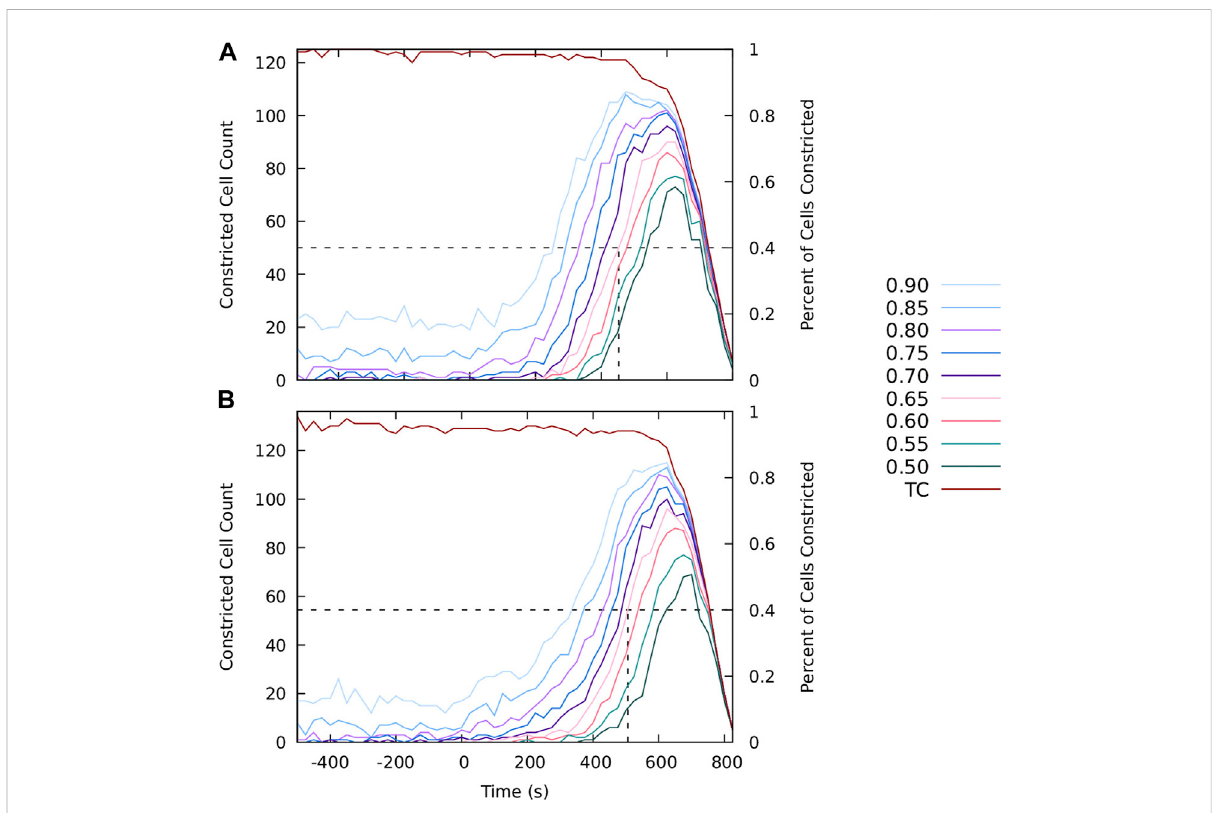
FIGURE 3 Theprogressionoftheapicalconstrictionprocess.Thegraphsshowthenumber(leftscale)andthefraction(rightscale)oftrackedcellswiththe area reduction factor r A smaller than the speci fi ed value (as labeled). The current number of tracked cells (TC) is also shown. At the onset of invagination the number of tracked cells decreases because the cells move out of the focal plane. The results for (A) Embryo 1 and (B) Embryo